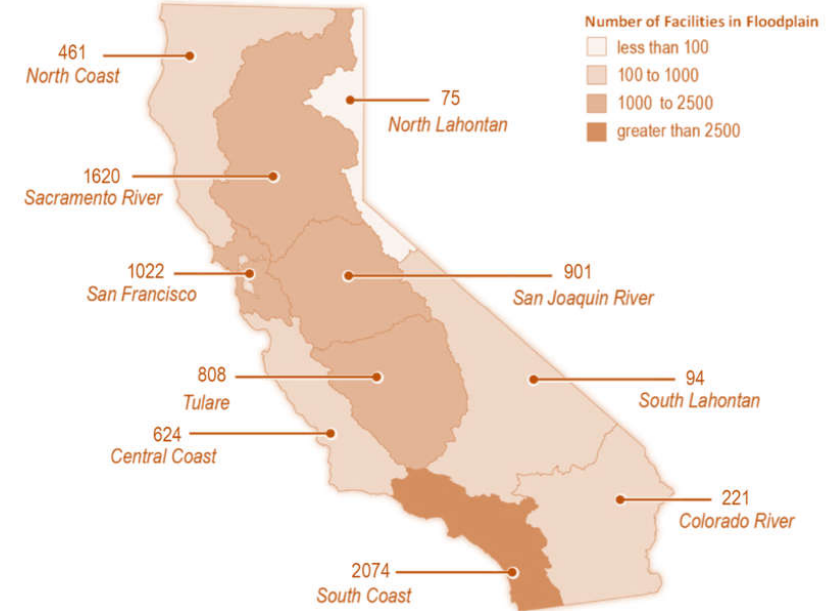
Figure 1. Transportation facilities within the floodplains by California hydrologic regions. Transportation facilities include highways, railroads, public transportation facilities, airports, etc. data from [27].